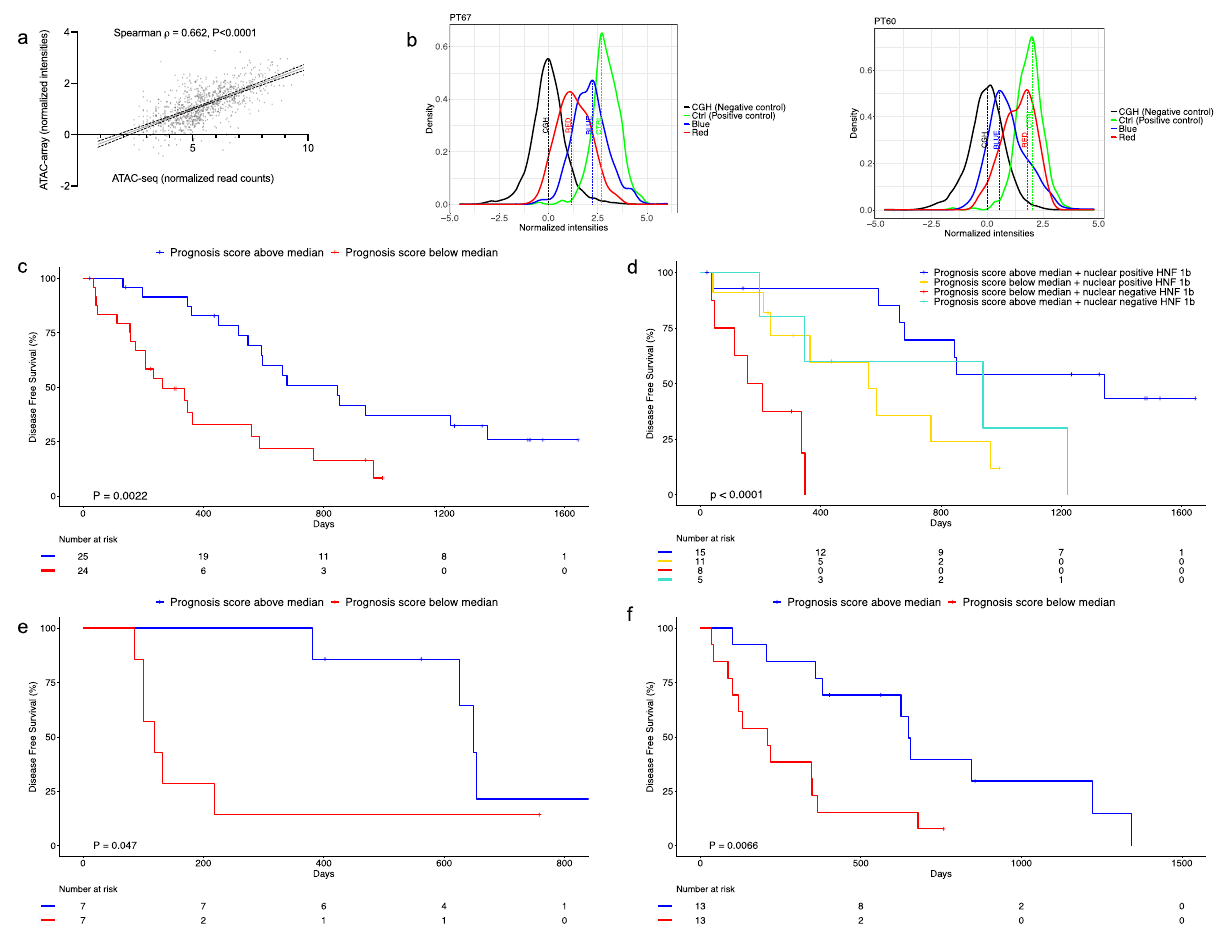
Fig. 4 ATAC-array correlates with ATAC-seq and predicts DFS. a ATAC-seq and ATAC-array correlation is shown in a representative patient (PT17). b Representative histograms showing good (blue distribution median intensity > red) prognosis and poor (red distribution median intensity > blue) prognosis ATAC-array signature in patient PT67 and PT60, respectively. (Source data are provided as a Source Data fi le). c Kaplan – Meier curve showing signi fi cant segregation of PDAC patients ( n = 49) on the basis of ATAC-array prognosis score (log-rank (Mantel – Cox) test P = 0.0022, HR 2.896, 95% CI 1.426 to 5.878). d Kaplan – Meier curve shows combination of ATAC-array and HNF1b nuclear localization segregates PDAC patients into four different groups with signi fi cantly different median DFS (log-rank (Mantel – Cox) test P < 0.0001, and log-rank test for trend P < 0.0001). e Kaplan – Meier curve showing signi fi cant segregation of PDAC organoids on the basis of ATAC-array Prognosis Score in an independent validation cohort ( n = 14) (log-rank (Mantel – Cox) test P = 0.0475, HR 3.228, 95% CI 0.8523 to 12.23). f Kaplan – Meier curve showing signi fi cant segregation of PDAC organoids on the basis of ATAC-array Prognosis Score in the pooled cohort ( n = 26) (log-rank (Mantel – Cox) test P = 0.0066, HR 2.860, 95% CI 1.144 to 7.145) (Source data are provided as a Source Data fi